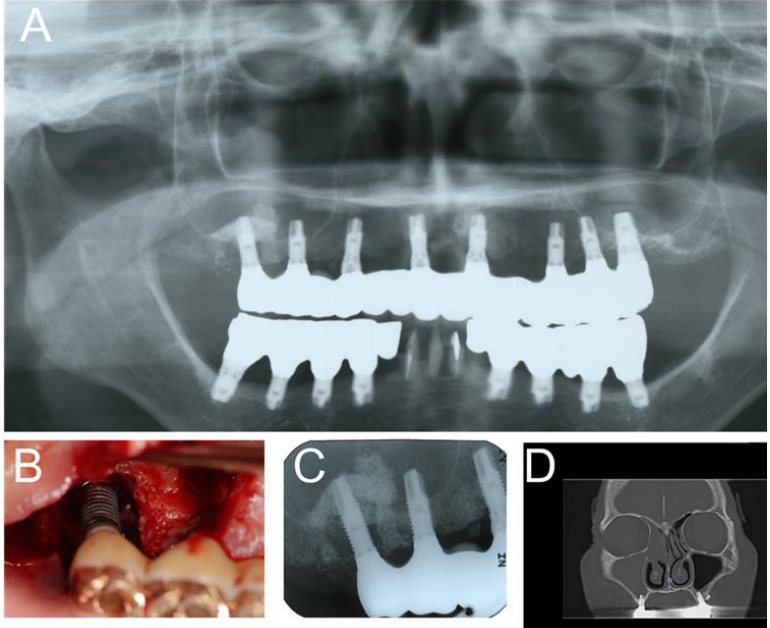
Figure 3. Severe peri-implantitis in the upper right molar region was observed 10 years after implant therapy with sinus augmentation. ( A ) Panoramic radiography; ( B ) oral photograph; ( C ) intraoral radiograph; ( D ) paranasal CT shows right rhinosinusitis. In this case, chronic maxillary sinusitis occurred through the pathway from peri-implantitis to the maxillary sinus for a long period. Therefore, FESS was performed (unpublished data).